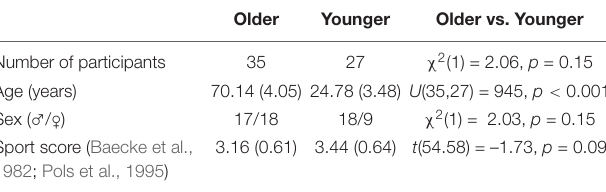
TABLE 1 | Between-group comparison of demographic and physical activity data. Older Younger Older vs.